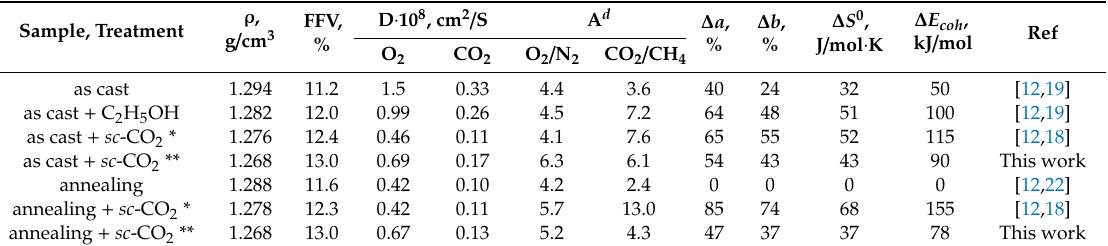
Table 1. Density, fractional free volume, di ff usion coe ffi cients, di ff usion selectivity, and relative changes in the parameters a and b , changes of entropy of the basic state and cohesion energy for Ultem films. ρ , Sample, Treatment g / cm